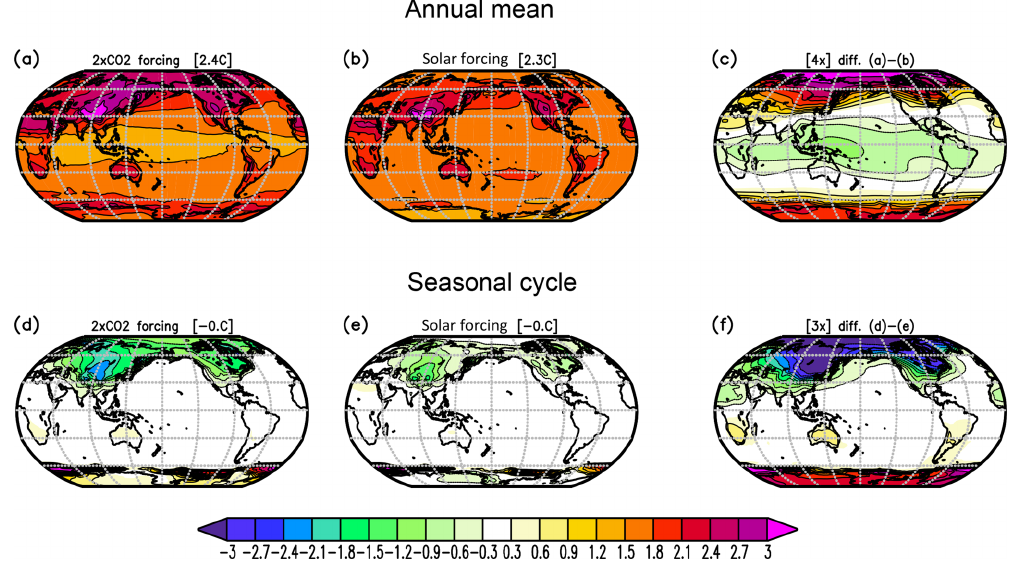
Figure 13. T surf response to changes in the solar constant by + 27Wm − 2 (b, e) versus a doubling of the CO 2 concentration (a, d) for the annual mean (a, c, c) and the seasonal cycle (d, e, f) . The seasonal cycle is defined by the difference between the months (JAS – JFM) divided by two. (c, f) The difference between panels (a) and (b) and between panels (d) and (e) , respectively, scaled by 4 (c) and 3 (f)